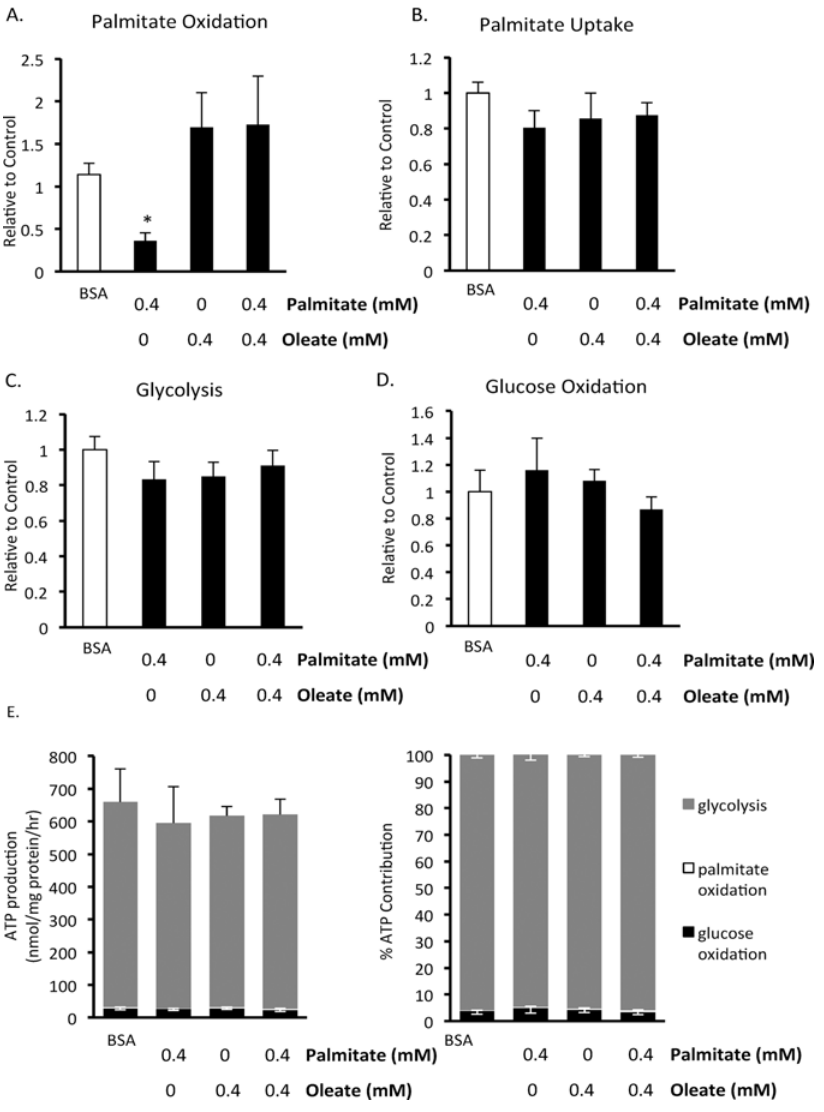
Fig 5. Effect of 24 hour exposure to fatty acids on human BMMSC energy metabolism. A) Palmitate oxidation, B) palmitate uptake, C) glycolysis, and D) glucose oxidation were measured in human BMMSCs that had been treated for 24 hr with either 0.55 mM albumin (BSA group) or 0.55 mM albumin and 0.4 mM palmitate and/or 0.4 mM oleate prior to these metabolism measurements being made. n = 5 – 8 The graphs indicate which groups were exposed to these different treatments for the 24 hr prior to the metabolism measurements. During each assay all groups were given Krebs buffer supplemented with 5 mM glucose and 0.4 mM palmitate bound to 0.55 mM albumin. In addition, the Krebs buffer was supplemented with either [U- 14 C]glucose, [1 – 14 C]palmitate, or [5 – 3 H]glucose for the measurement of glucose oxidation, palmitate oxidation and uptake, or glycolysis, respectively. E) The contribution of metabolic pathways to ATP production were calculated from the metabolic rate results. * Significantly different from all groups. Values are shown as mean ±